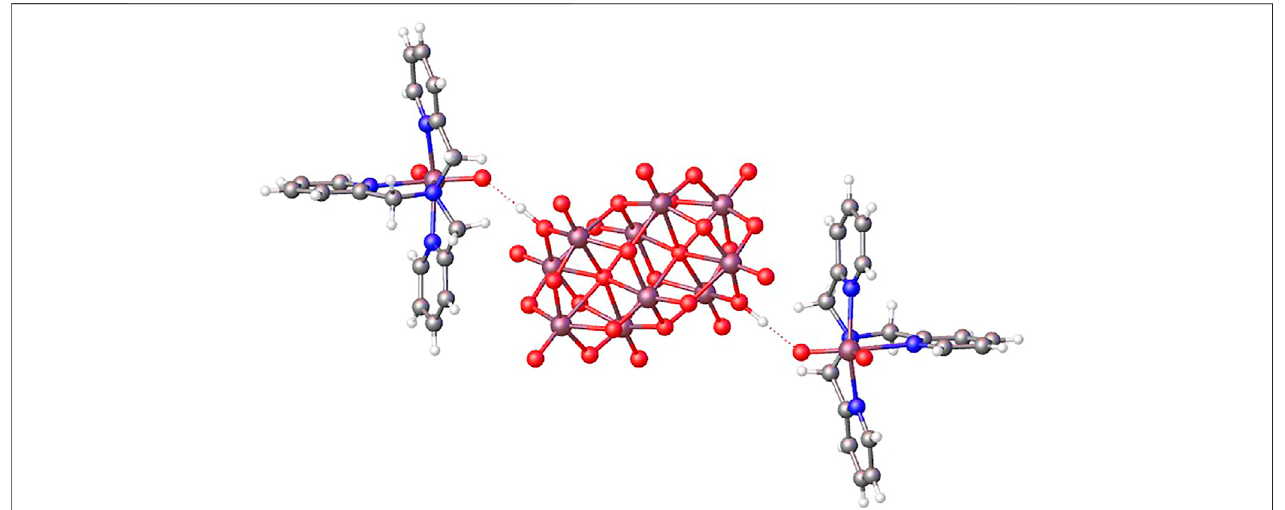
FIGURE 3 | OLEX representation of hydrogen bonds connecting both species of